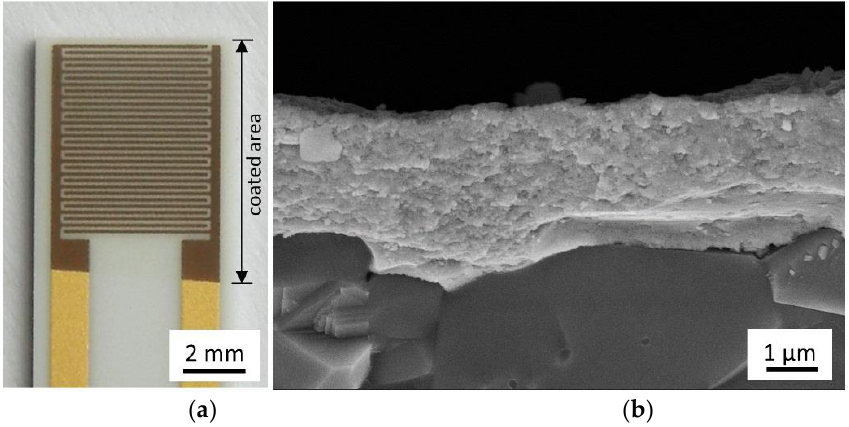
Figure 4. ( a ) Coated and at 600 °C annealed IDE structure and ( b ) SEM micrograph of fractured cross section of film on Al 2 O 3 substrate.